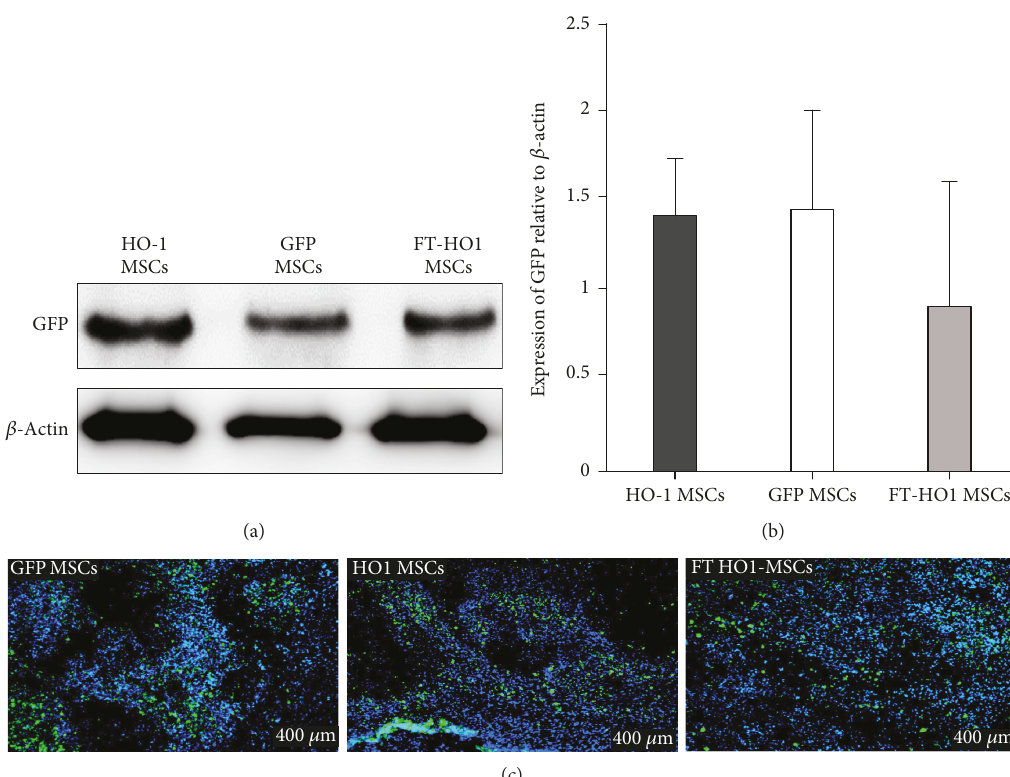
Figure 3: Migration of injected cells at the injured spinal cord segment following 4 weeks of experimental period. (a) Representative densities of GFP protein in groups obtained through western blot analysis of tissue lysate. (b) Depiction of the quantitative expression of GFP protein relative to β -actin. Each bar represents the average of 4 samples in a group and error bars represent standard error. (c) Immunostaining for the location of transplanted cells at the injured spinal cord segment. The nuclei are stained blue and GFP protein is stained green, demonstrating the migration of transplanted cells. Each fi gure is obtained with a scale bar of 400 μ m.